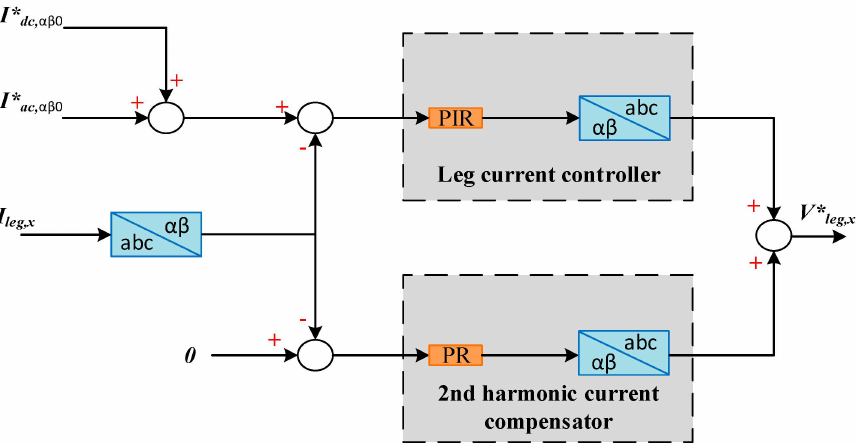
Figure 22. Control scheme of a leg controller and second harmonic compensator in MMC